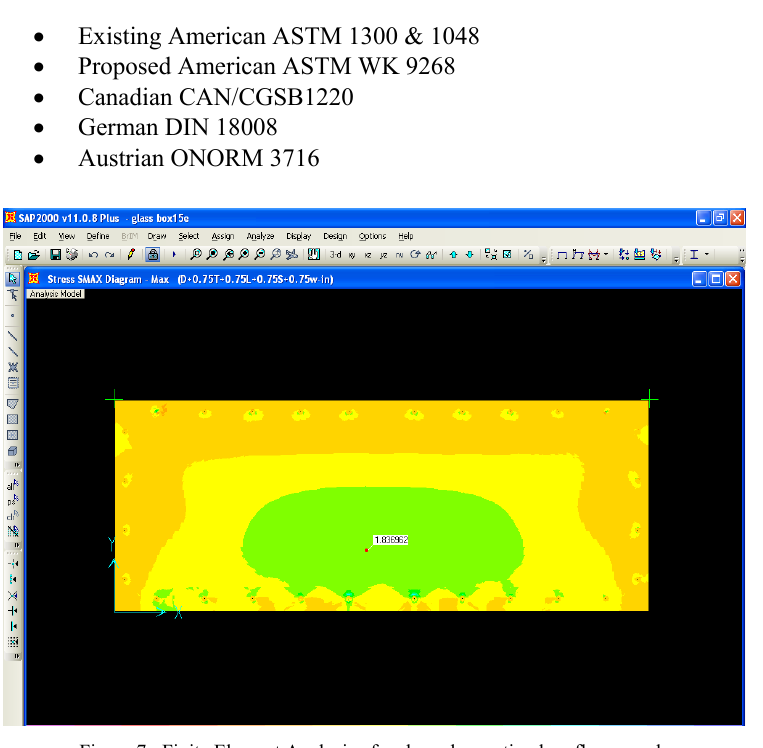
Figure 7: Finite Element Analysis of a glass observation box floor panel